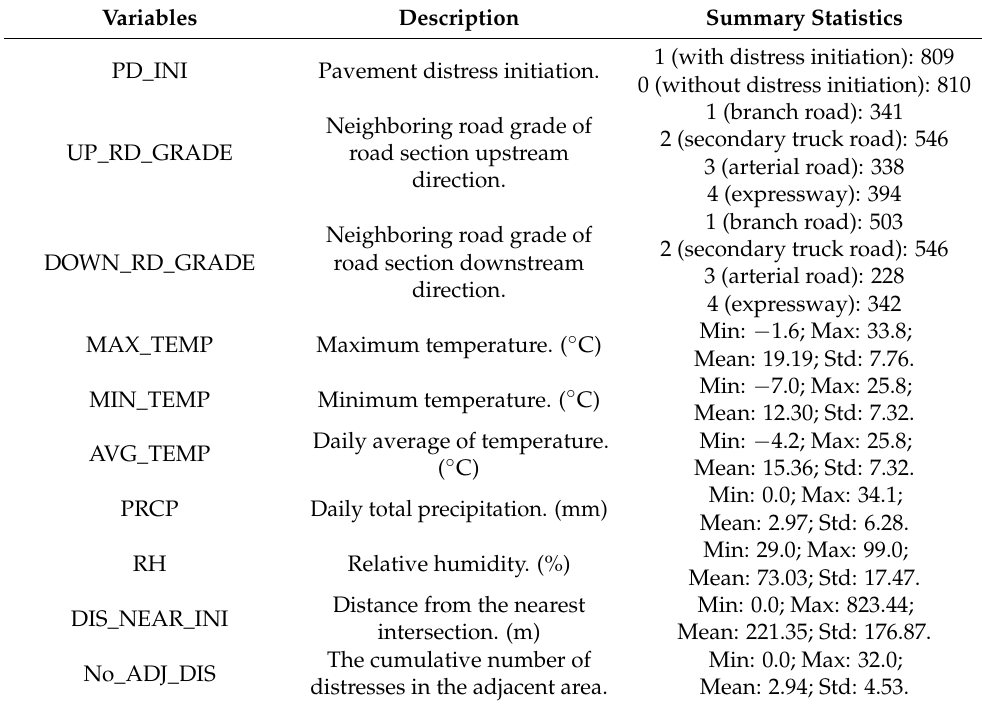
Table 1. Summary Statistics of the Dependent and Independent